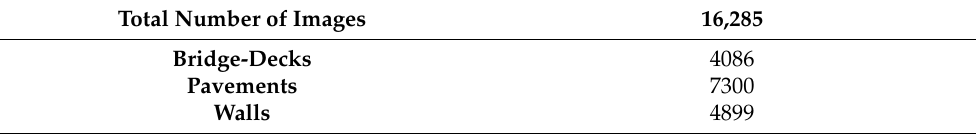
Table 2. Cross-image datasets.